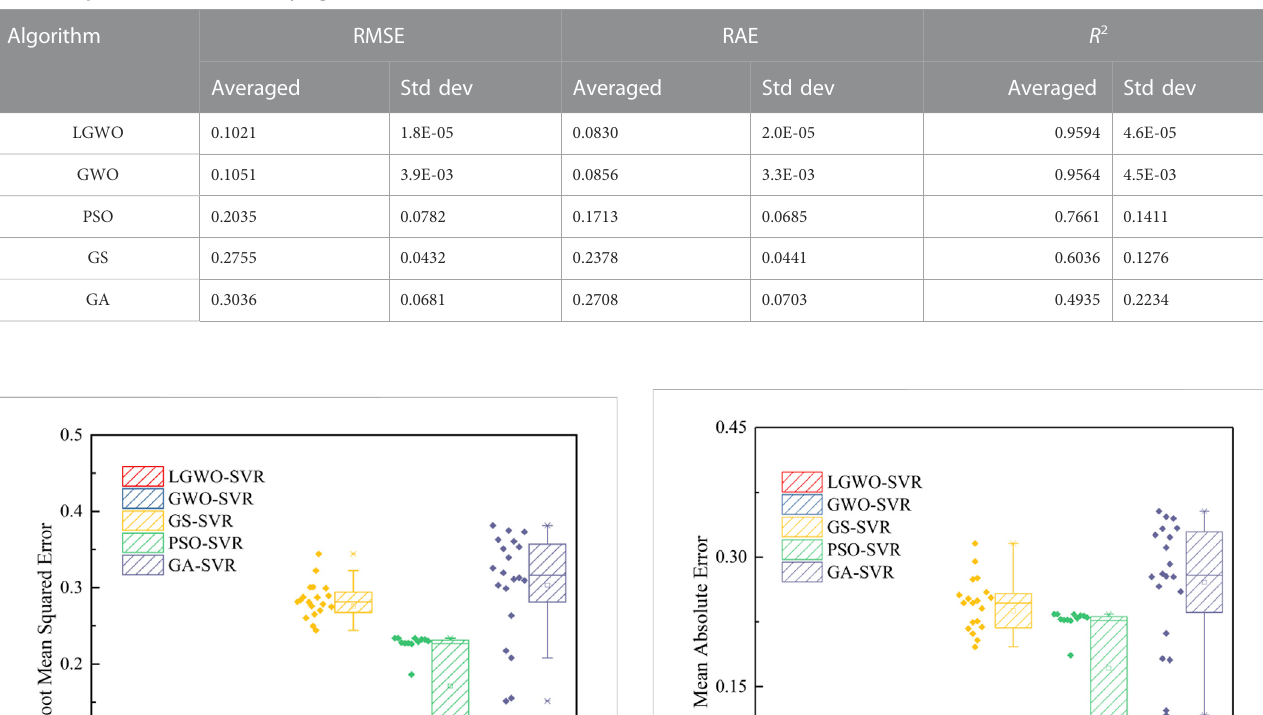
TABLE 2 Experimental results of every algorithm.